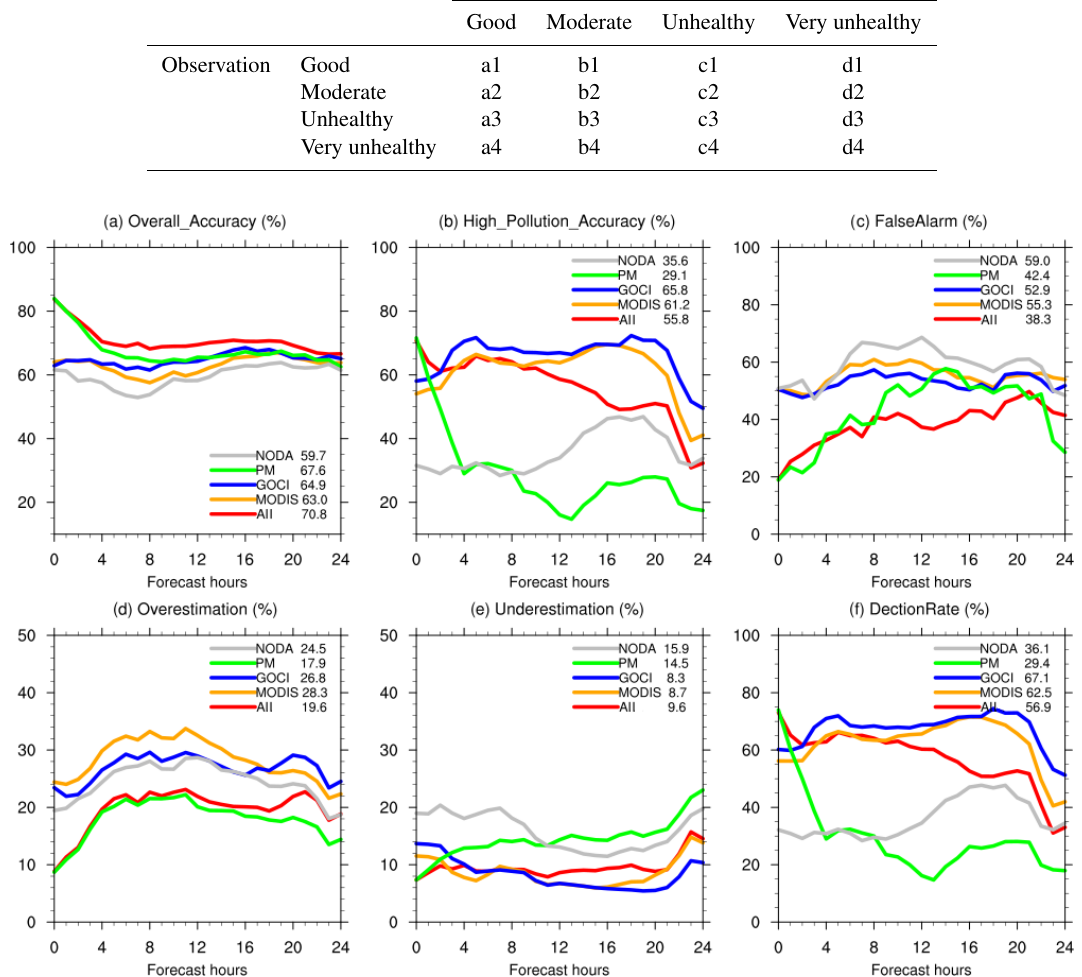
Figure 11. Time series of the forecast accuracy (%) of the hourly forecasts from the 00:00UTC initialization for 4–31 May 2016 in domain 2 for categorized events based on hourly surface PM 2 . 5 concentrations, as defined in Tables 2 and